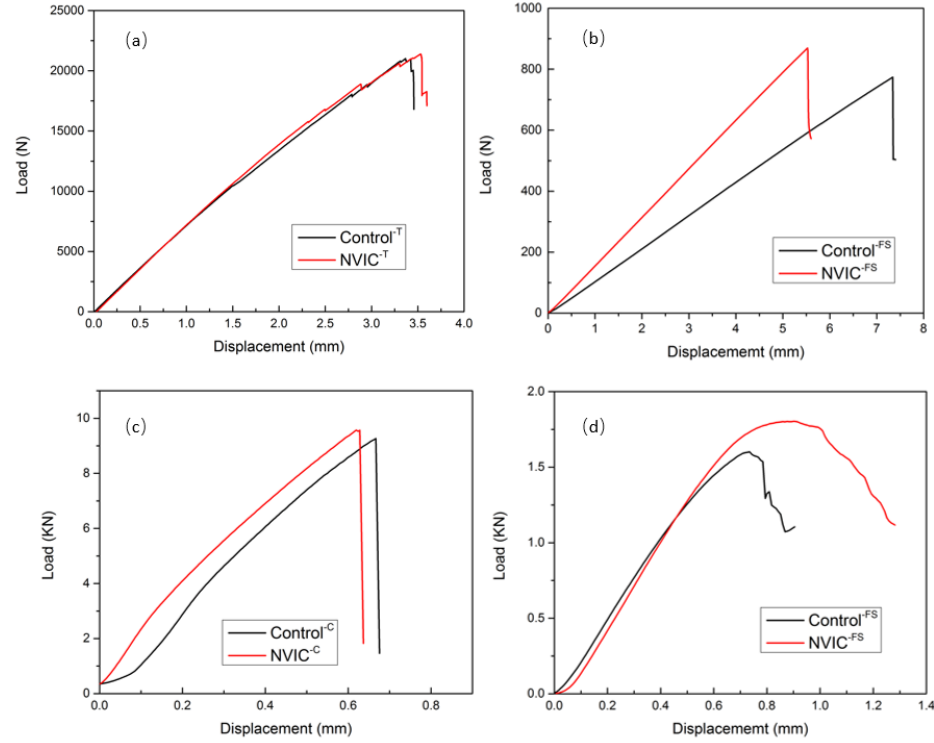
Figure 18. Load-displacement curves of in-plane mechanical test. ( a ) Tensile, ( b ) flexural, ( c ) compressive, and ( d ) interlaminar